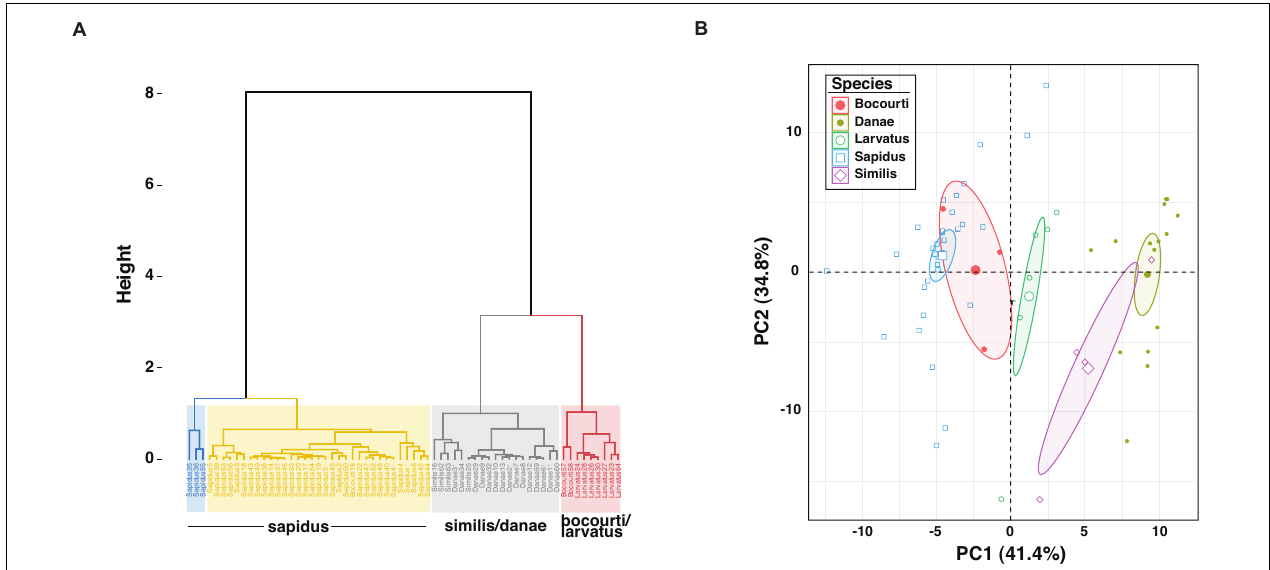
FIGURE 4 | Cluster and PCA results for high resolution melt curve (HRM) data. (A) Shows the hierarchical K-means clustering results for the 64 melt curves for k = 4 clusters. Individual samples are named by their 12S Sanger sequence-based species identification ( C. sapidus , Sapidus; C. danae , Danae; C. similis , Similis; C. bocourti , Bocourti; C. larvatus , Larvatus) and the species composition of each cluster is summarized in the text below each cluster. C. sapidus HRM data were resolved into two separate clusters (blue and yellow), while C. similis and C. danae formed a single cluster (gray) as did C. bocourti/larvatus (red). (B) Shows PCA results for the HRM data, with samples from each species identified as a distinct color. Ellipses represent the 95% confidence ellipses. Each axis displays the proportion of the total variability explained by each principle component or PC.